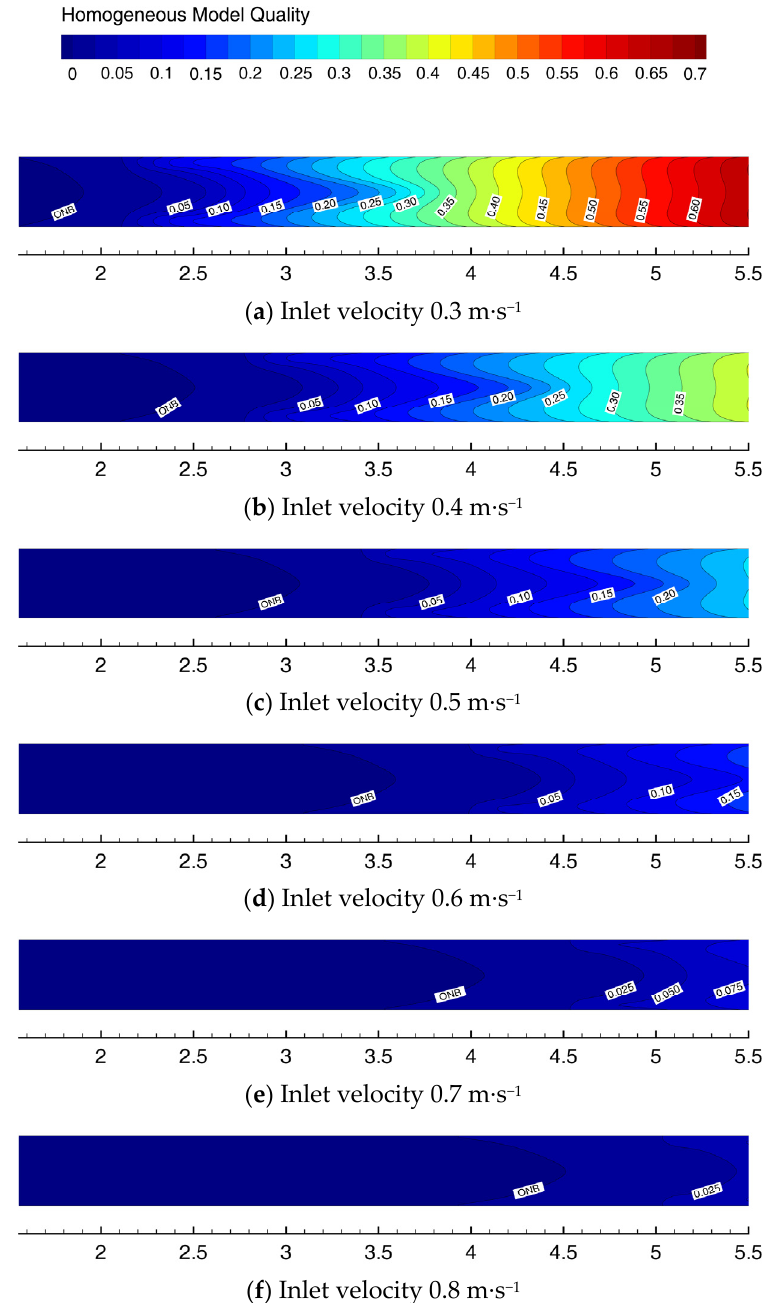
Figure 13. Homogeneous model quality distributions at inlet velocities ranging from 0.3 m·s − 1 to 0.8 m·s − 1